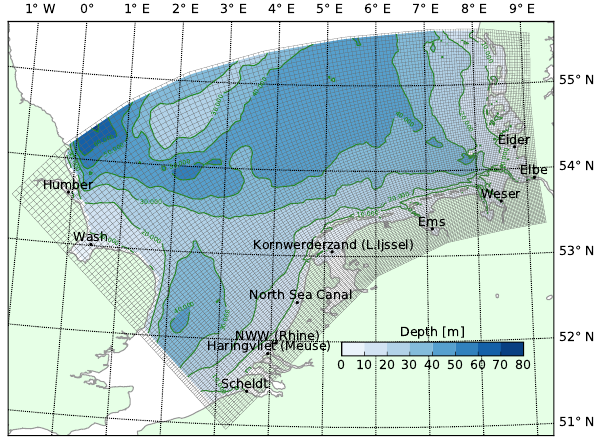
Figure 1. Bathymetry of the model domain and the location of rivers considered in this study. Gray lines display the model grid.